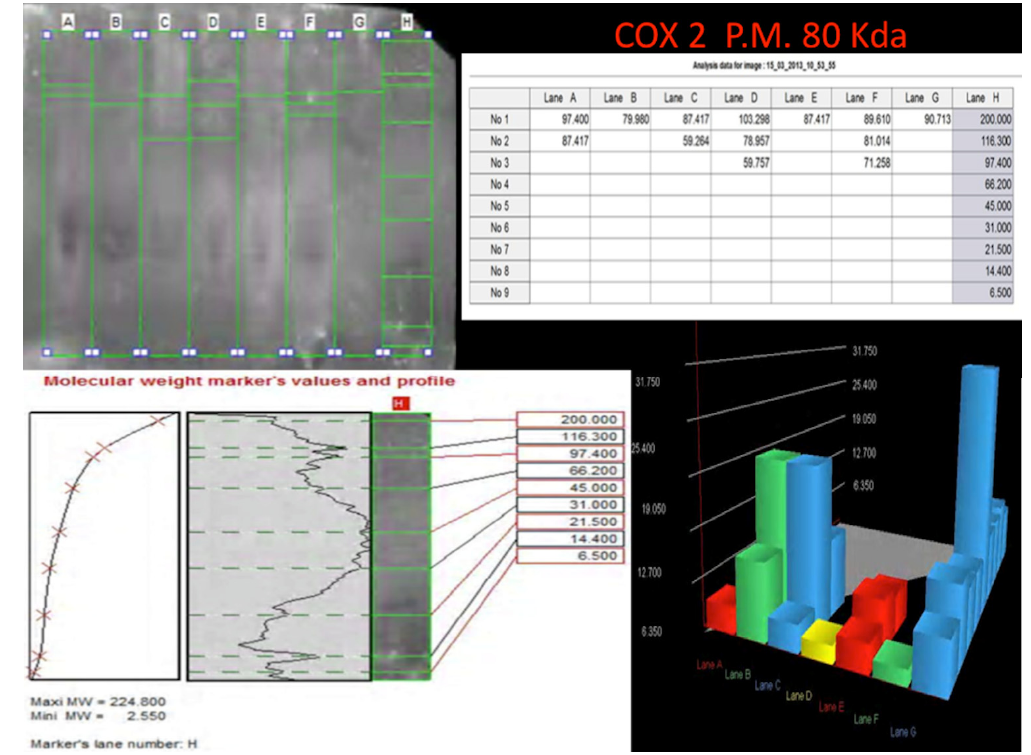
Figure 10. Western blotting quantitatively measured by densitometry, confirming the reactions of intense positivity for COX-2. Densitometry using cytoplasmic and nuclear extracts from frozen brain for each group, confirming the weak positivity reactions for heroin-related group. The higher result is on line (heroin group) C. Marker’s lines on the right side of the blot